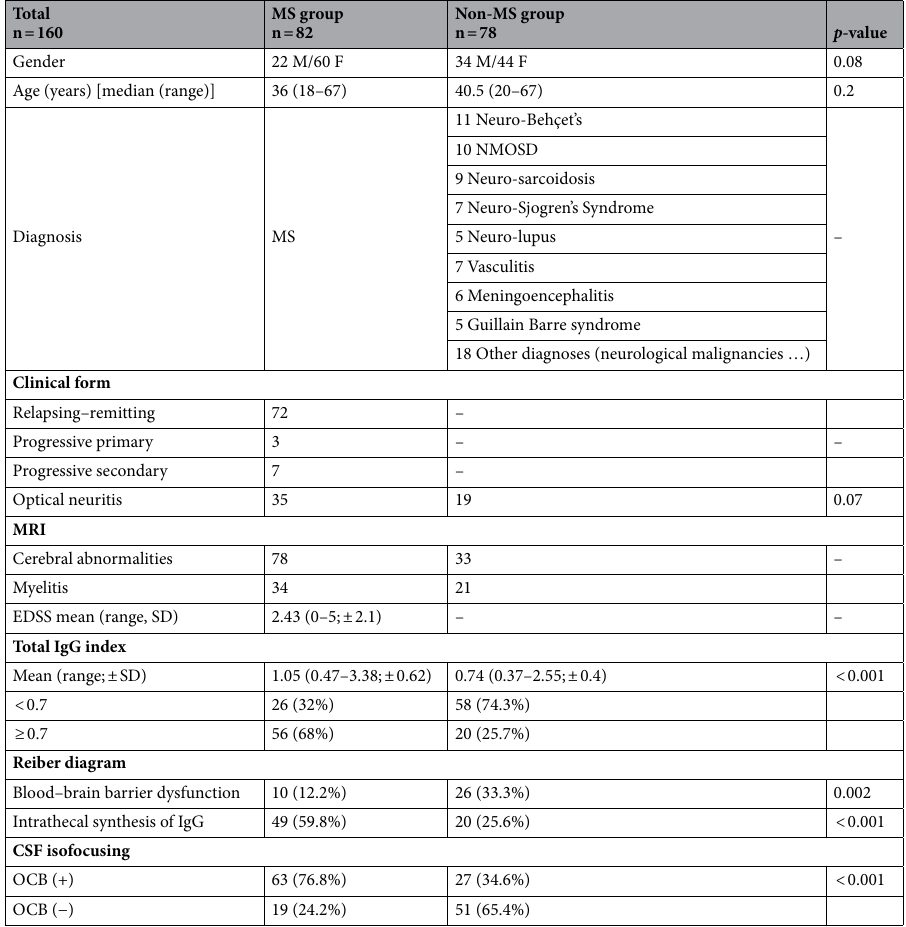
Table 1. Clinical, radiological and immunological features of the study population. MS multiple sclerosis, NMOSD neuromyelitis optica spectrum disorder, MRI magnetic resonance imaging, EDSS expanded disability status scale, CSF cerebrospinal fluid, OCB oligoclonal